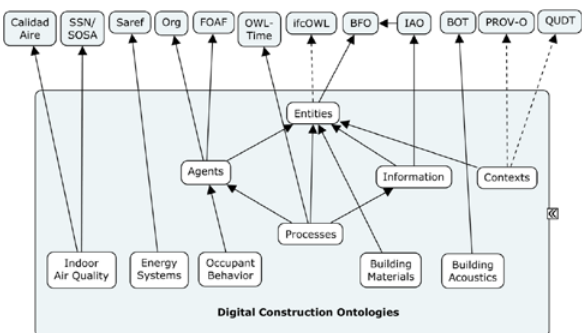
Figure 5 - Digital Construction Ontologies for the BIM4EEB- Linked Data Modelling & Sharing Framework